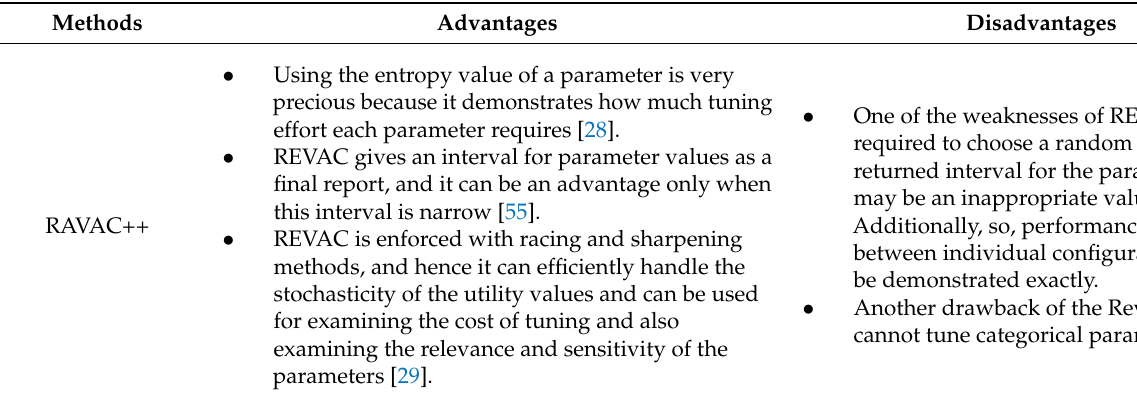
Table 1. A summary of the advantages and disadvantages of widely-used model-free algorithm configuration